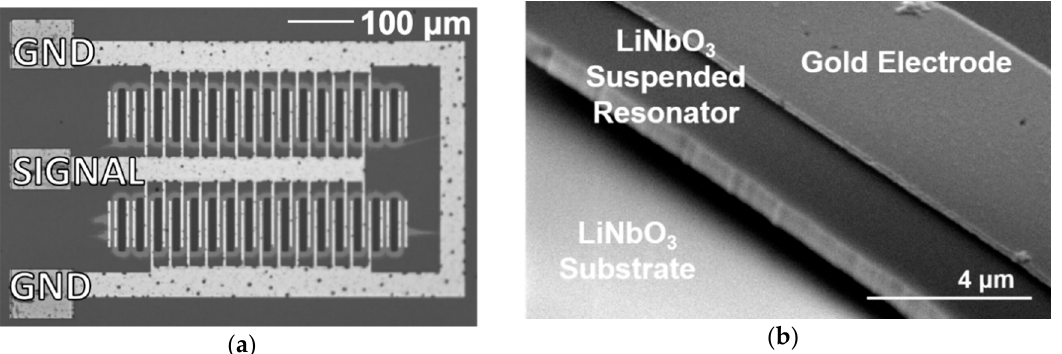
Figure 1. The microfabricated LN MEMS LVR array. Top-view optical image ( a ) and tilted SEM image of an individual resonator within the array ( b ).